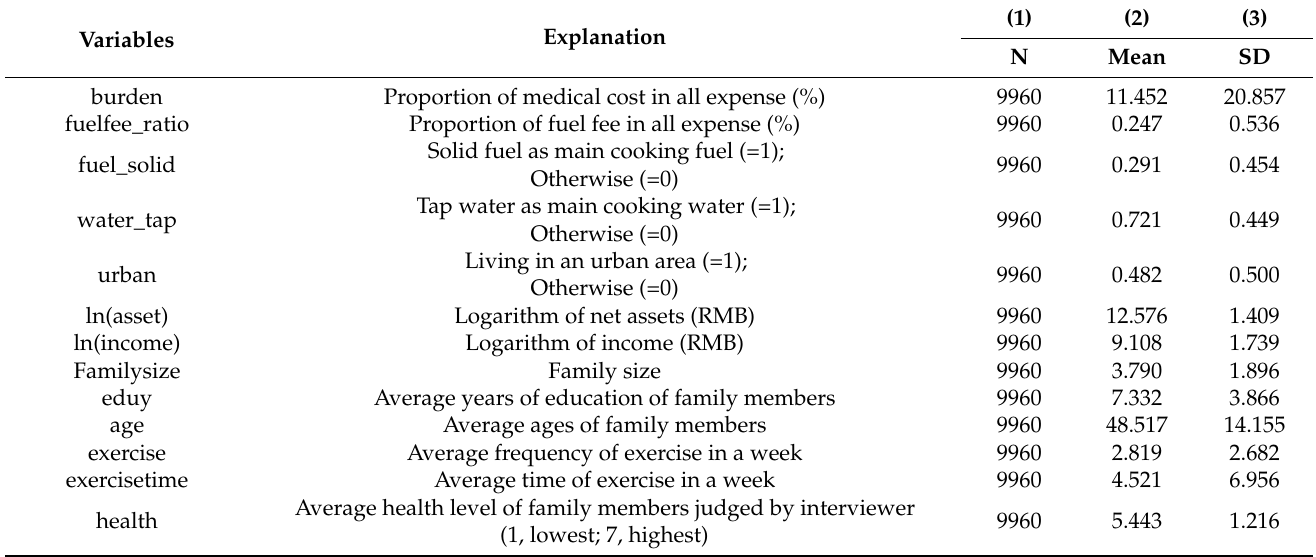
Table 1. Descriptive statistics of household fuel use and related